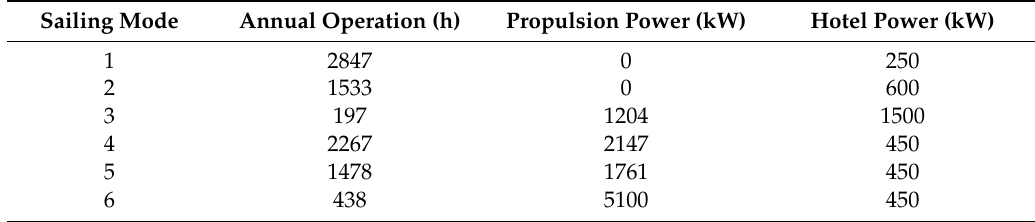
Table 3. Cargo ship: estimated propulsion and hotel power requirements in the various sailing modes.